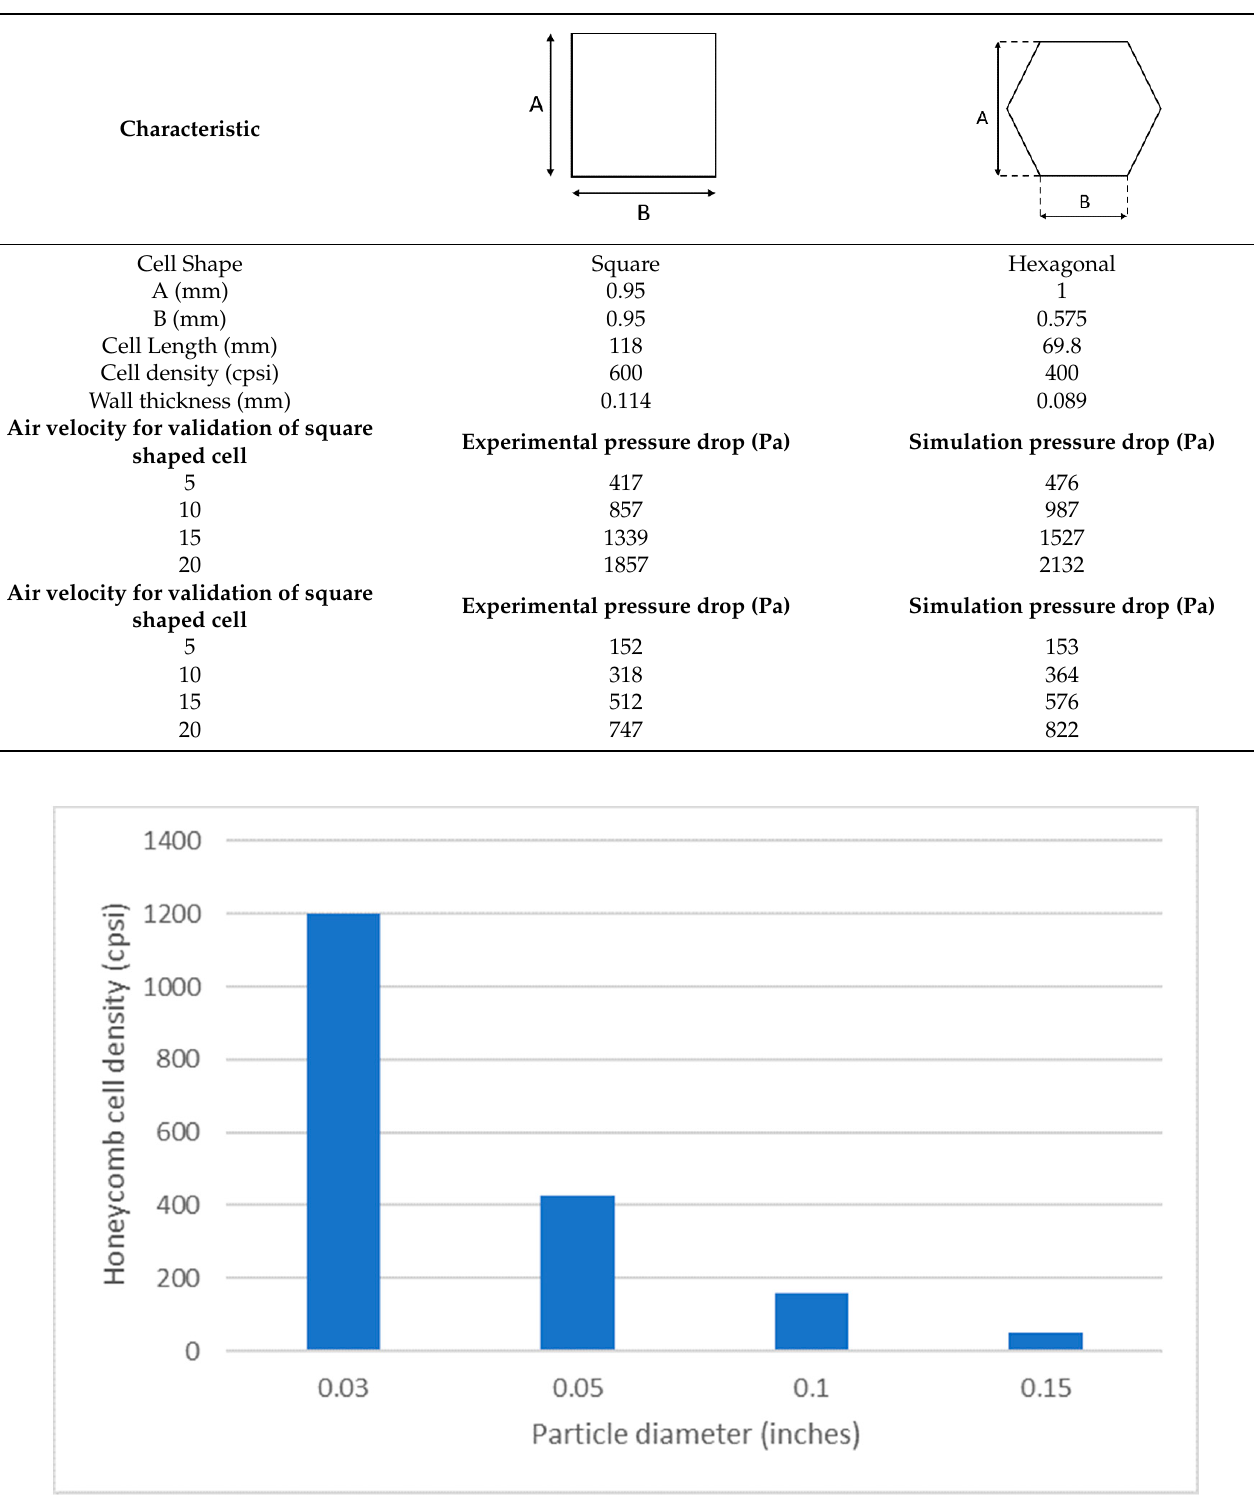
Table 4. Geometries of single channel for a square and hexagonal shaped cell, and validation of experiments. Adapted from [55].